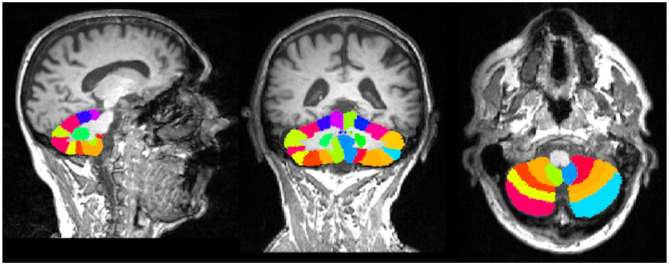
Spatially unbiased infratentorial toolbox (SUIT) cerebellar atlas aligned in the native subject space of individual multiple sclerosis (MS) patients.